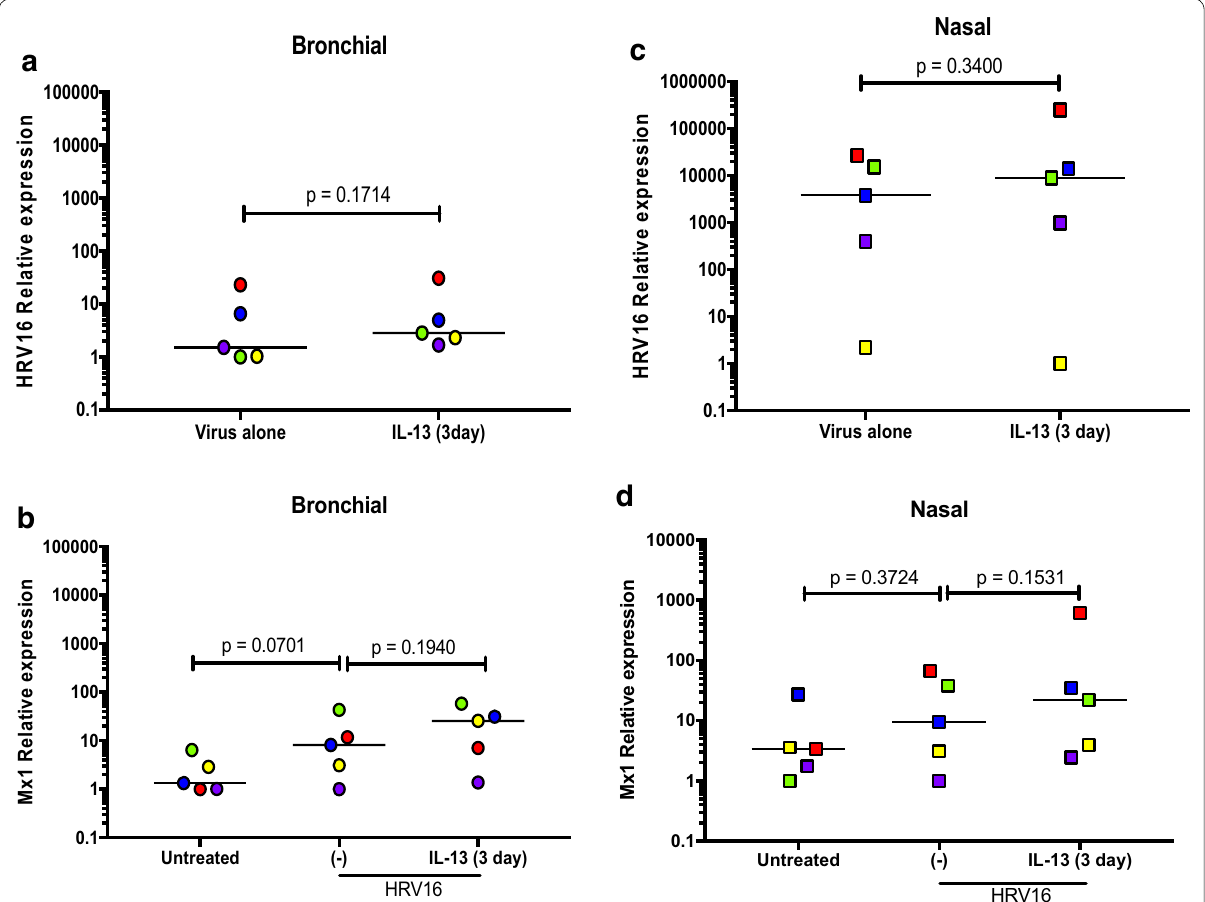
Fig. 6 Effects of IL-13 treatment on human rhinovirus 16 (HRV16) infection in paired human primary bronchial and nasal epithelial cells under the submerged culture. Viral load and Mx1 mRNA expression were measured in bronchial ( a , b ) and nasal ( c , d ) epithelial cells exposed to IL-13 and/or HRV16. Each of the colored solid circles (n 5 subjects) represents the data from an individual subject. The horizontal lines indicate =